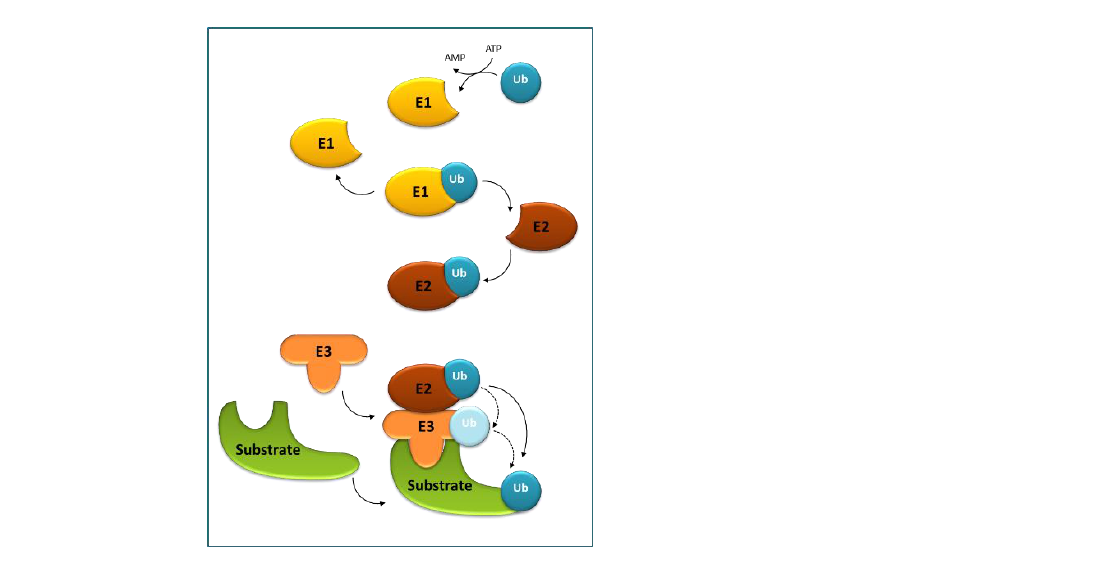
Figure 2. The ubiquitination cascade. Ubiquitin-activating enzyme (E1) activates ubiquitin (Ub) in an ATP-dependent manner, and next the thioester-linked Ub is transferred to Ub-conjugating enzyme (E2). Subsequently, E2 enzymes catalyze the attachment of Ub to a substrate using Ub ligase (E3). E3s, responsible for substrate recognition, transfer Ub either directly from E2 or form an E3–Ub intermediate prior to the transfer.